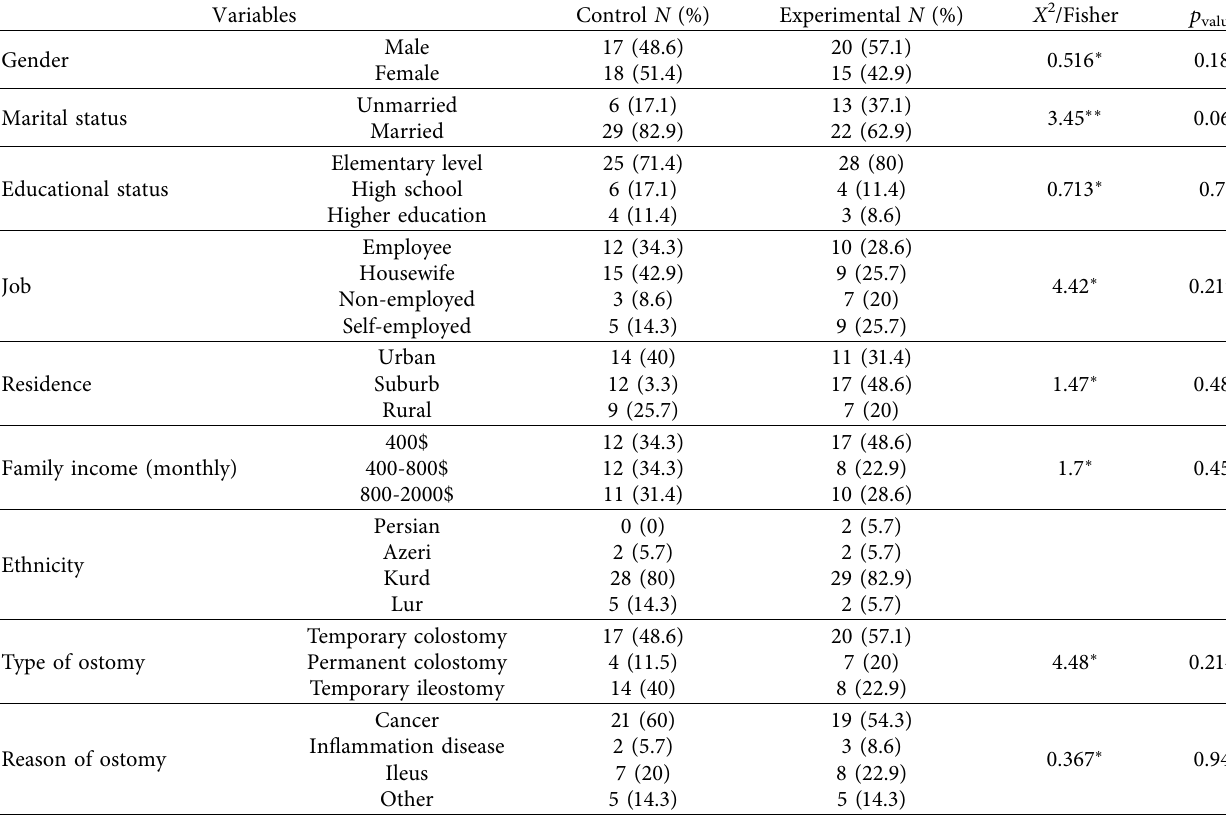
Table 1: Relative and absolute frequency of the experimental and control groups based on the demographics.